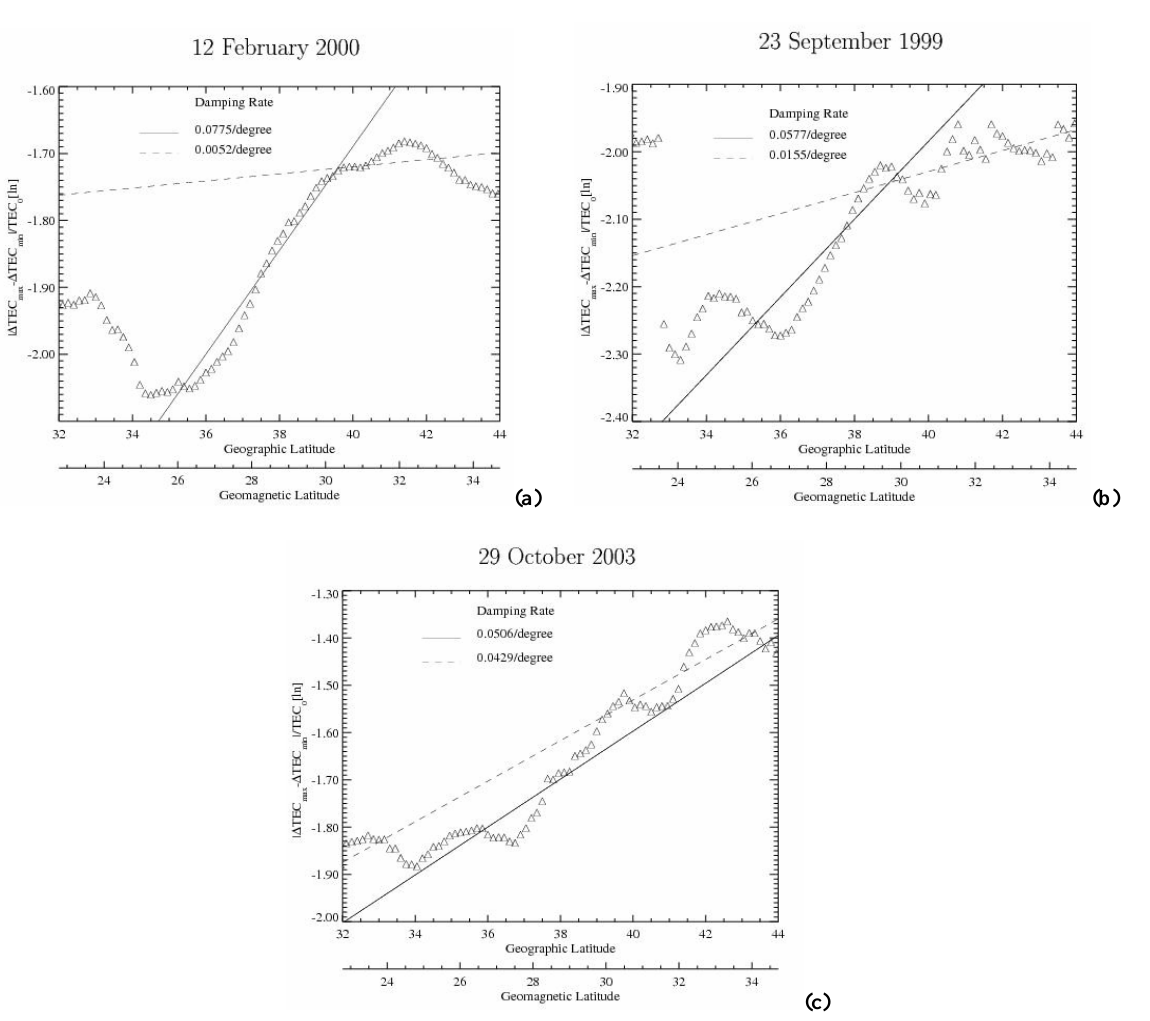
Fig. 4. The latitudinal variations of the amplitudes of TEC enhancements, | (1 TEC max − 1 TEC min ) | /TEC 0 , are plotted as triangles on (a) 12 February 2000, (b) 23 September 1999, and (c) 29 October 2003. The latitudinal damping rate was found from the gradients of the least-squares fitted lines drawn at latitude sectors 44–39 ◦ N (dashed line) and 39–34 ◦ N (continuous line),